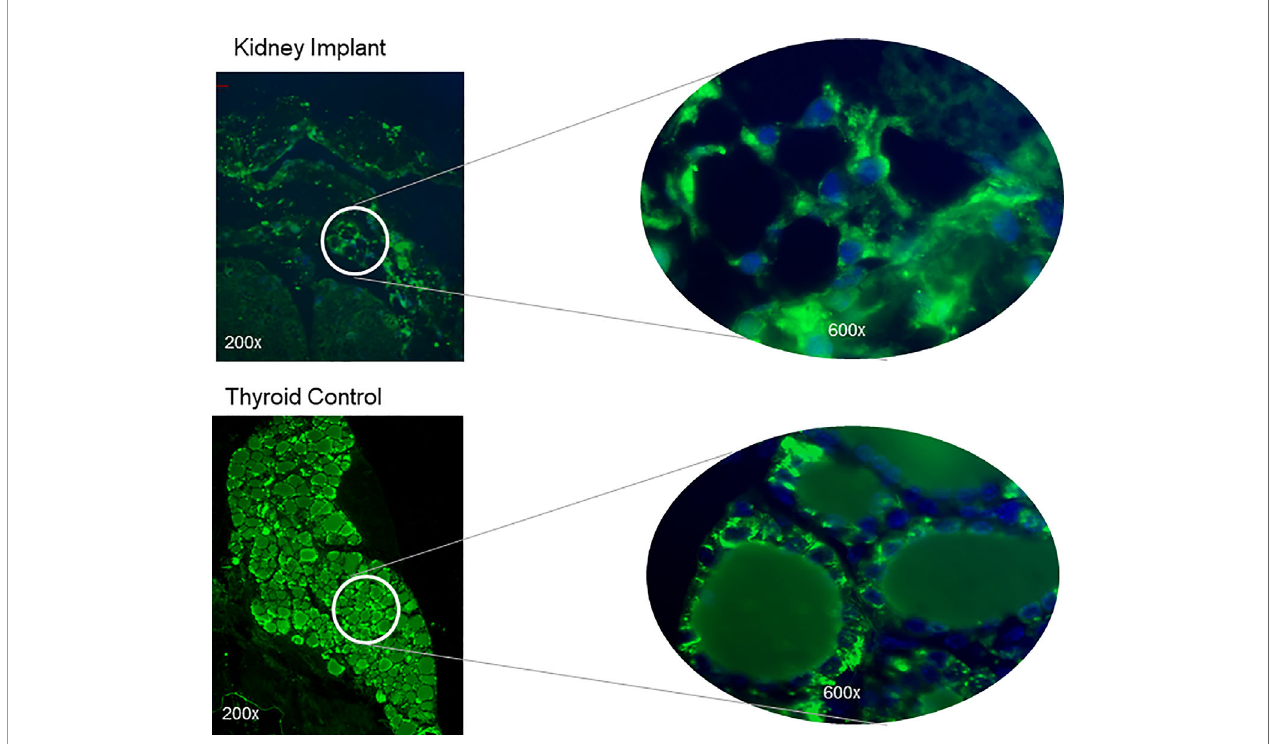
FIGURE 11 | Tg expression in thyroid follicles at 20 weeks. Kidney sections of the implanted tissue were analyzed for expression of TG protein by using a polyclonal anti-Tg antibody. The top panel shows magni fi ed images showing intracellular staining of Tg in the thyroid follicles without strong staining in the central colloid. The nuclei were stained blue with Dapi. A control normal thyroid section stained at the same time following the same protocol is shown below. Strong intracellular staining of the follicular cells was